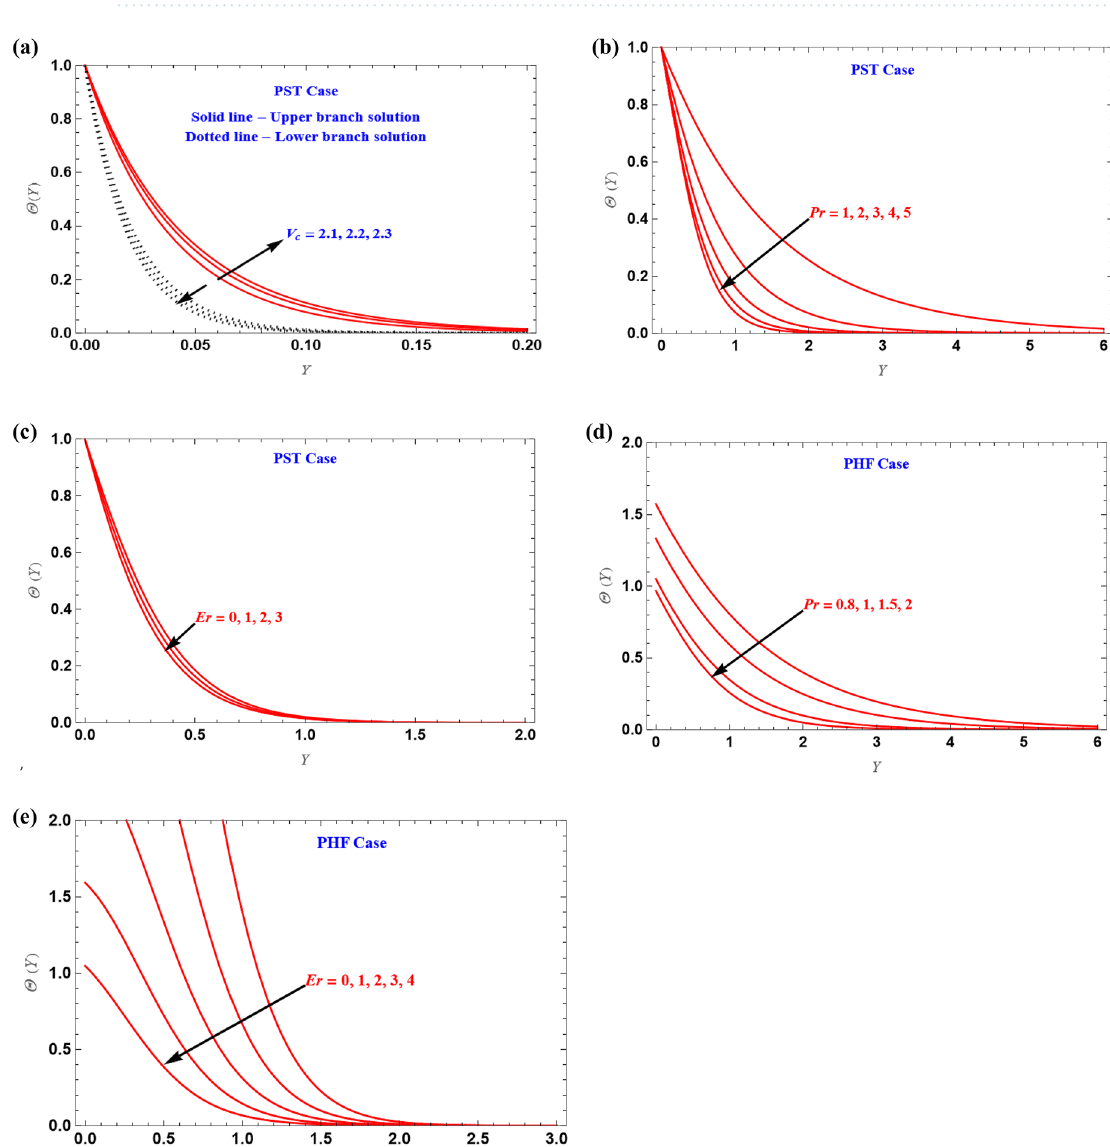
Figure 7. ( a – e ) Solution of heat versus similarity